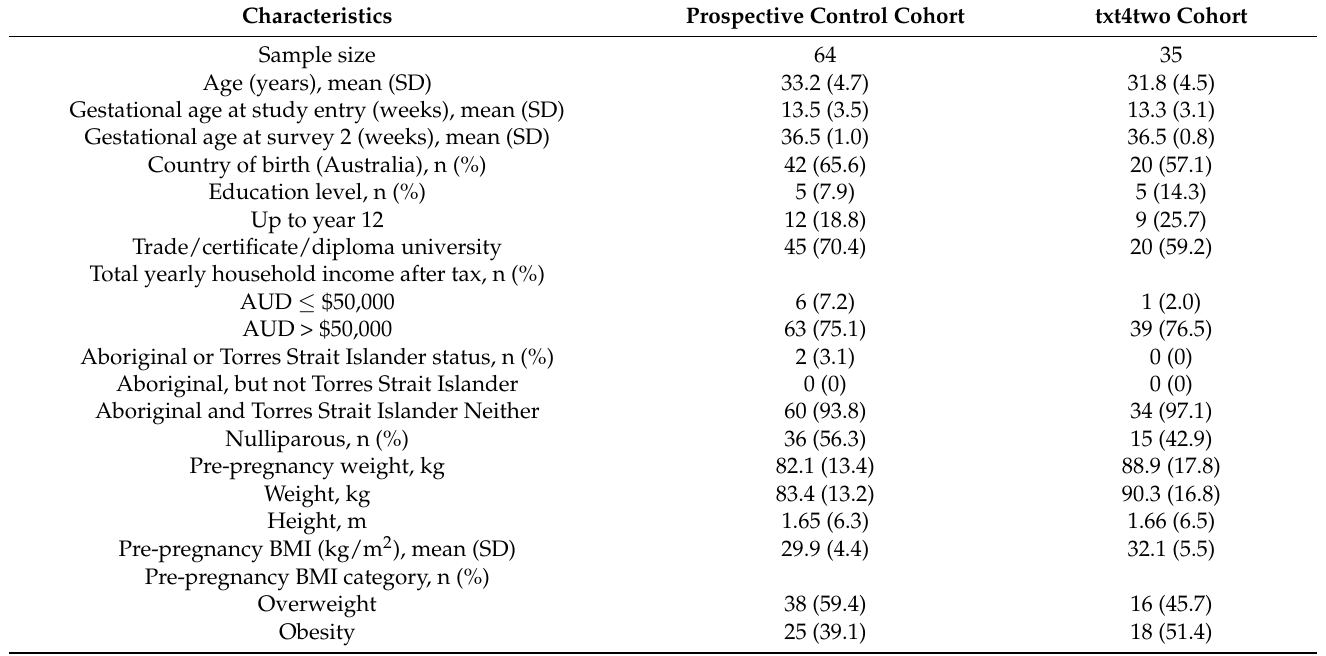
Table 1. Characteristics of the prospective control and txt4two (intervention) cohorts a